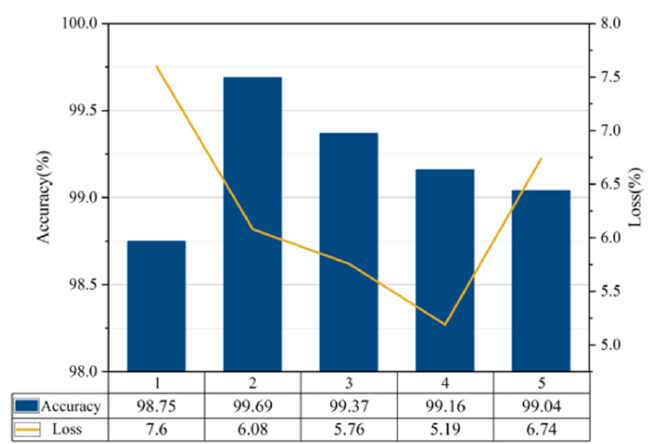
Figure 18. Accuracy and loss rates for multiple tests.